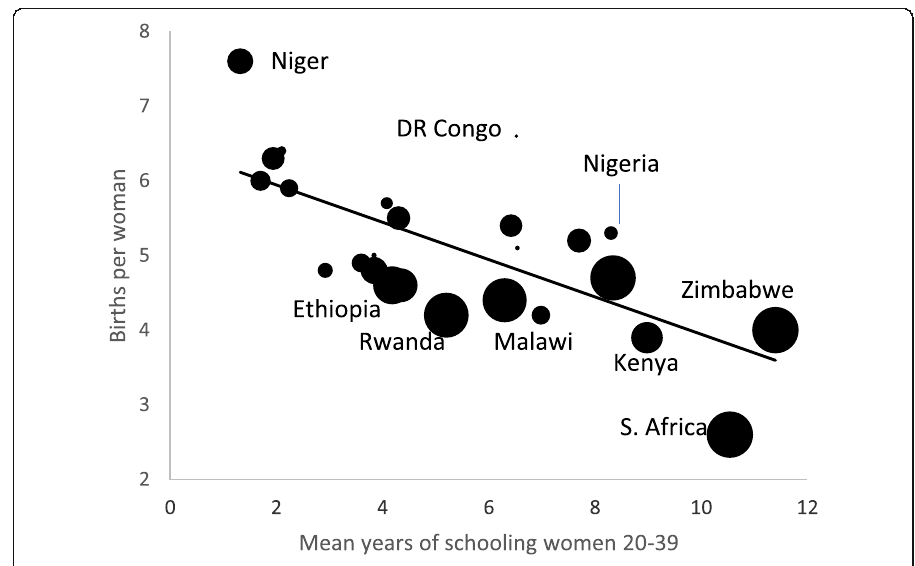
Fig. 4 Total fertility rate by level of education and program score, 25 countries in sub-Saharan